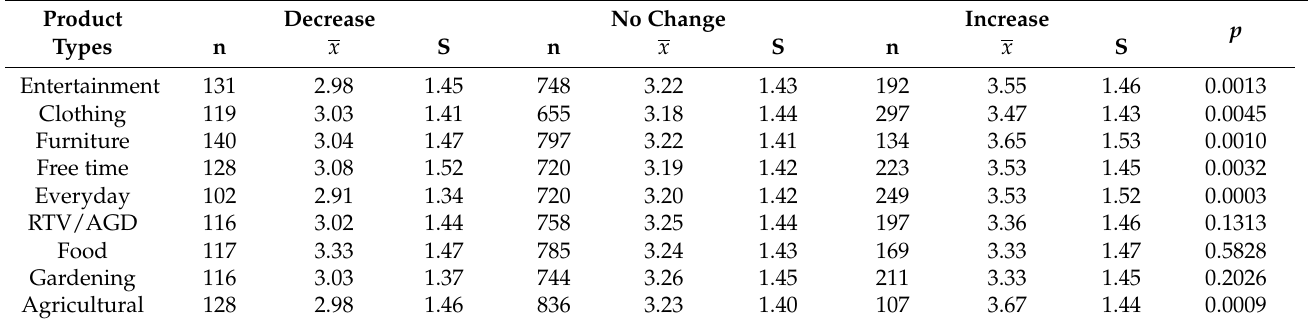
Table 8. Relation between the number of persons in the rural household and the frequency of online purchases before and during the COVID-19 pandemic (own